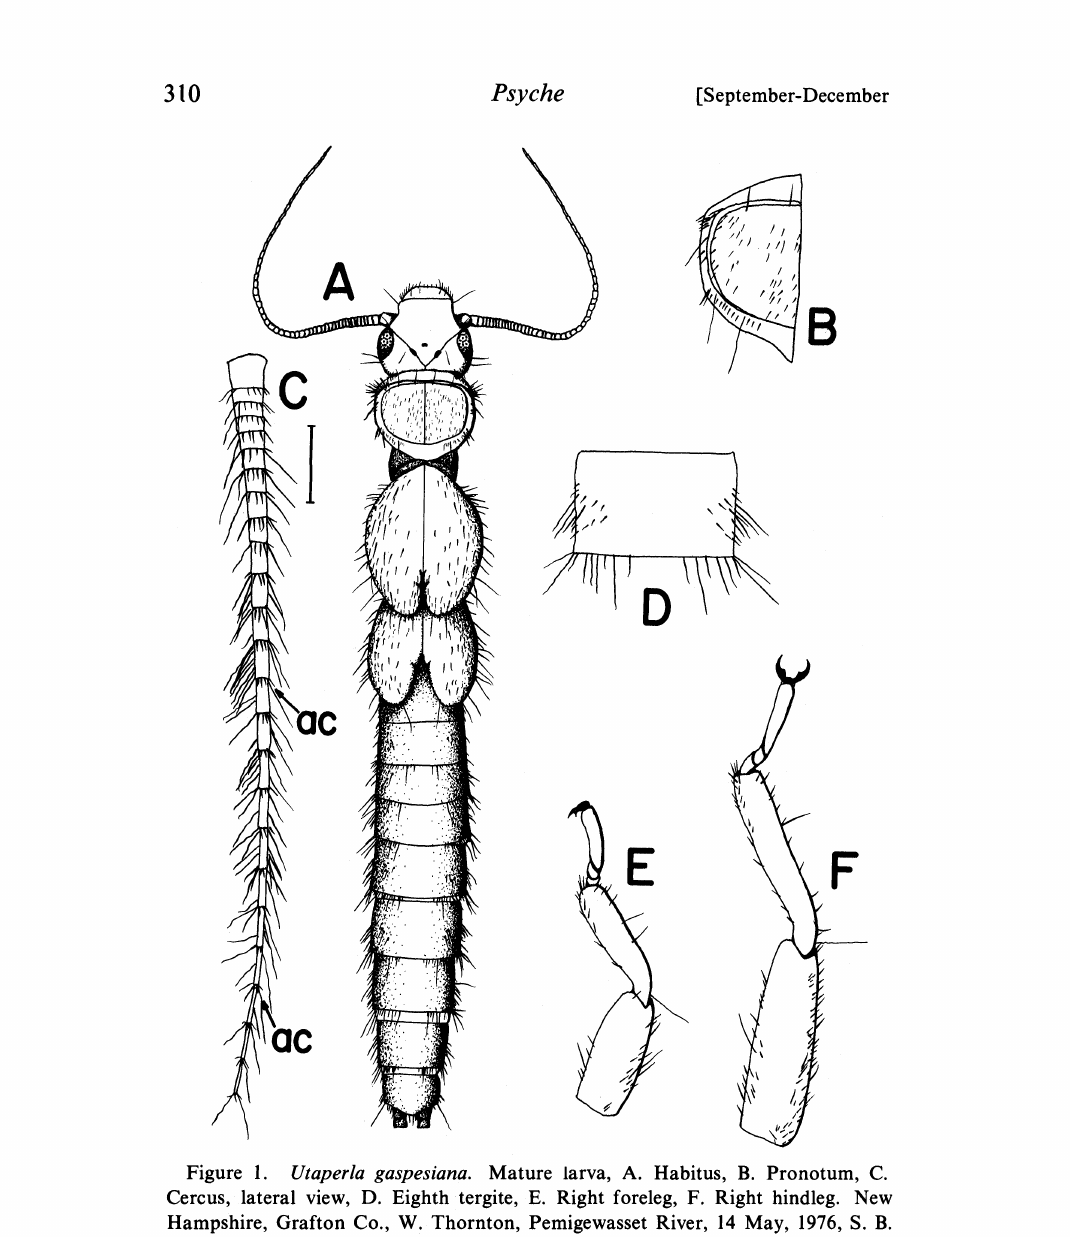
Figure 1. Utaperla gaspesiana. Mature larva, A. Habitus, B. Pronotum, C. Cercus, lateral view, D. Eighth tergite, E. Right foreleg, F. Right hindleg. New Hampshire, Grafton Co., W. Thornton, Pemigewasset River, 14 May, 1976, S. B. Fiance. (Scale: vertical bar A- mm, B-F- .5 mm; ac apical